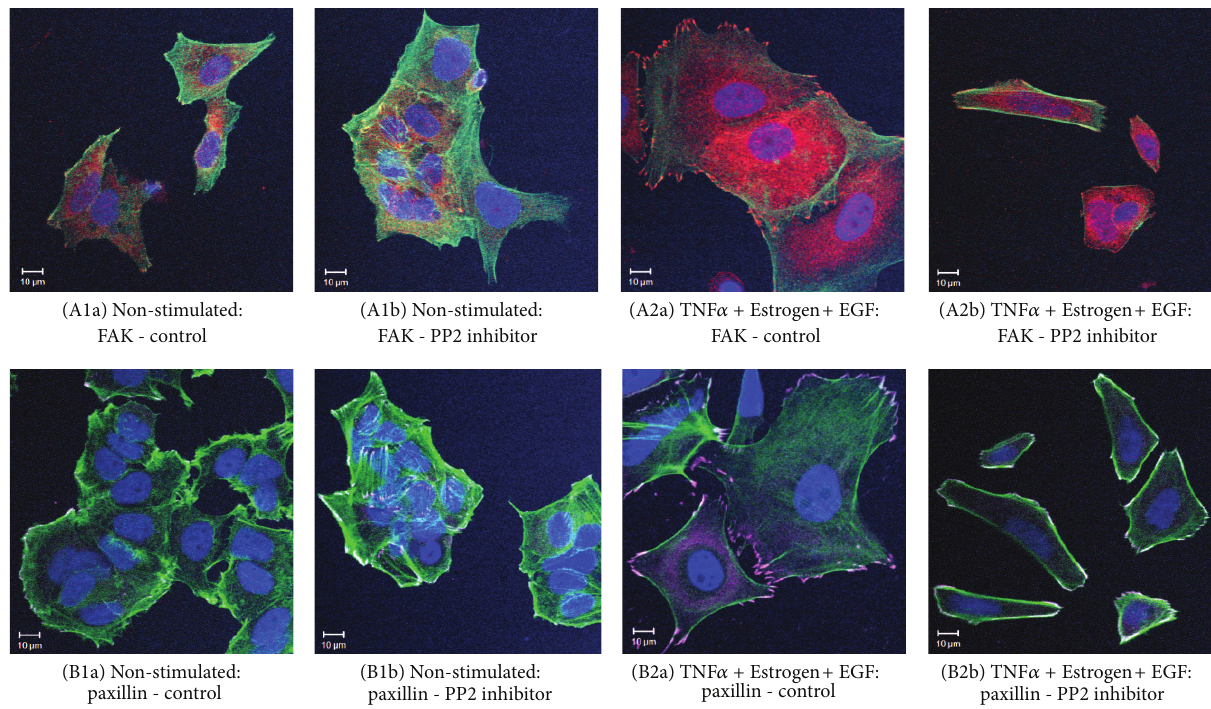
Figure 3: Cell-remodeling of breast tumor cells, induced by TNF 𝛼 + Estrogen + EGF, depends on Src-induced mechanisms. Breast tumor cells were stimulated by TNF 𝛼 + Estrogen + EGF (concentrations as in Figure 1) for three days. Non-stimulated: cells grown with the diluents of the above factors. The cells were either not exposed or exposed to the Src inhibitor PP2 (used at the range of 2.5–5 𝜇 M). (A) The expression of FAK, determined in the absence ((A1a), (A2a)) or in the presence ((A1b), (A2b)) of PP2 (2.5 𝜇 M in this specific experiment) in non- stimulated cells ((A1a), (A1b)) or in cells stimulated by TNF 𝛼 + Estrogen + EGF ((A2a), (A2b)). FAK expression was detected by specific Abs (red), actin filaments by phalloidin staining (green), and cell nuclei by DAPI staining (blue). In all panels, the results are from a representative experiment of 𝑛 ≥ 3 . (B) The expression of paxillin, determined in the absence ((B1a), (B2a)) or in the presence ((B1b), (B2b)) of PP2 (2.5 𝜇 M in this specific experiment) in non-stimulated cells ((B1a), (B1b)) or in cells stimulated by TNF 𝛼 + Estrogen + EGF ((B2a), (B2b)). Paxillin expression was detected by specific Abs (purple), actin filaments by phalloidin (green), and cell nuclei by DAPI staining (blue). In all panels, the results are from a representative experiment of 𝑛 = 3